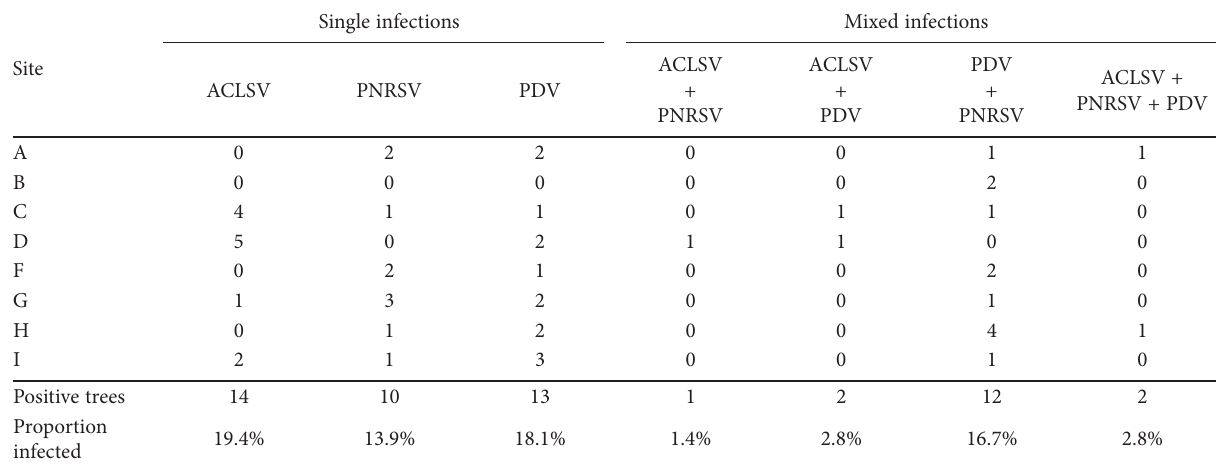
Table 5. Number of trees tested positive by RT-PCR for apple chlorotic leaf spot virus (ACLSV), Prunus necrotic ringspot virus (PNRSV), and prune dwarf virus (PDV), either in 2018 and 2020 or both years. Nine trees were tested in each of eight orchards (based on 72 sam-